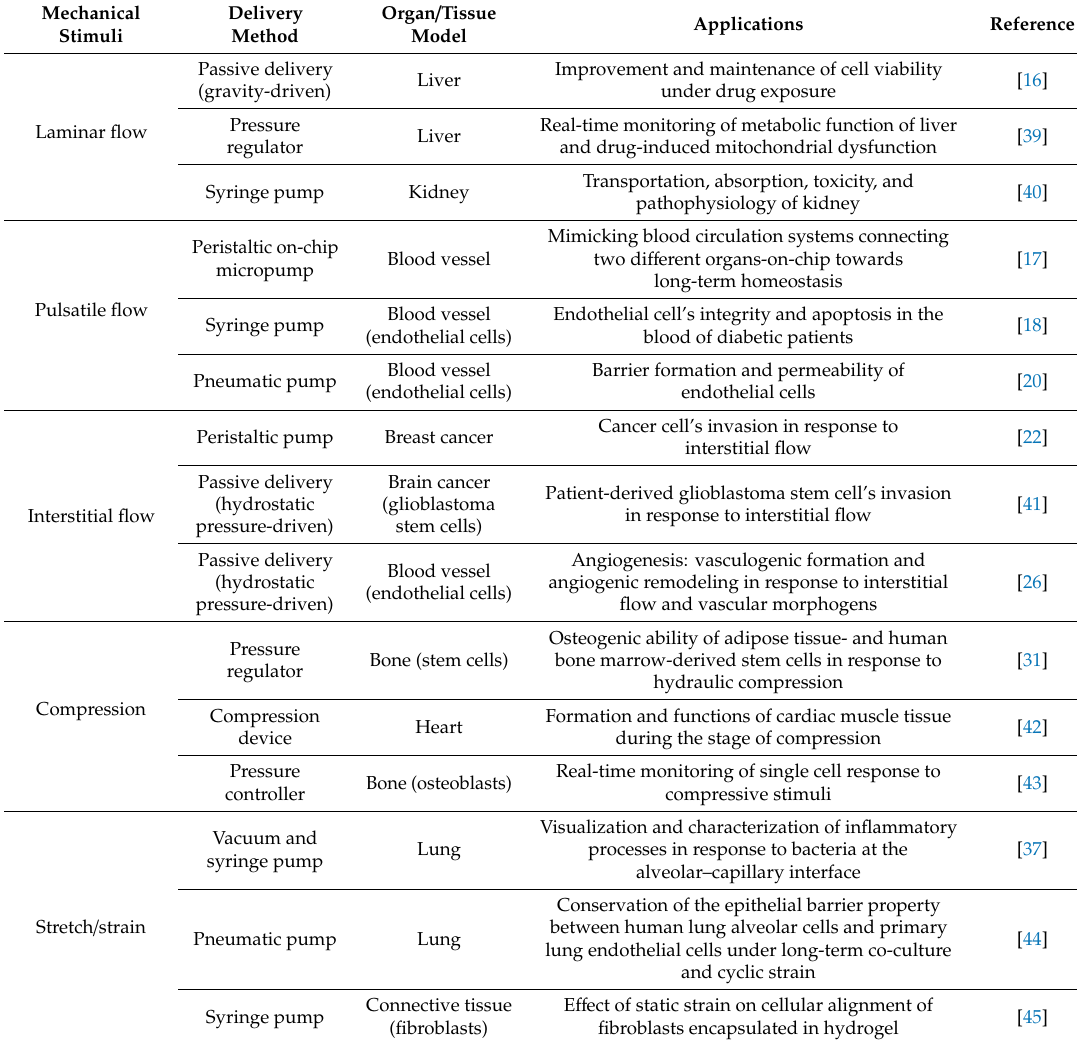
Table 1. Summary of di ff erent types of mechanical stimuli and delivering mechanisms towards various organ / tissue models and their